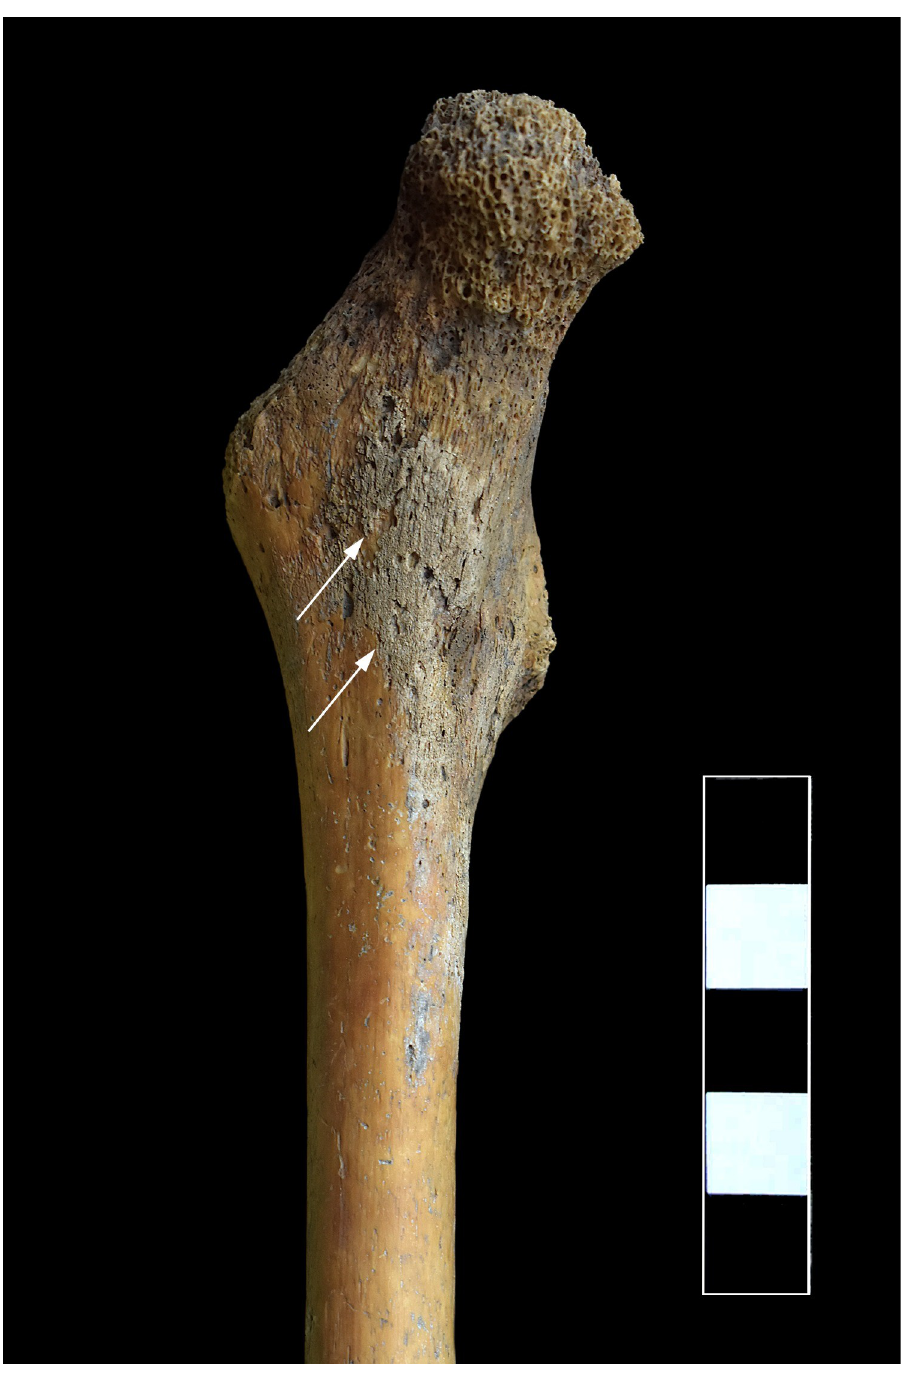
Fig 13. Reactive new bone formation on the anterior surface of the right femur (proximal end) (white arrows). of the right femur. The 12-year-old child’s case shows a number of similarities to those of pre- viously described in the paleopathological literature [e.g., 45, 49, 50, 55, 56]. Sparacello and his co-workers [49] reported a probable case of pediatric multifocal OATB (i.e., PO21) from Middle Neolithic Italy. Similarities with S0603 include involvement of the